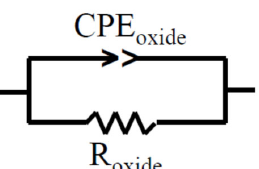
Figure 2. Electrical equivalent circuit used to fit impedance